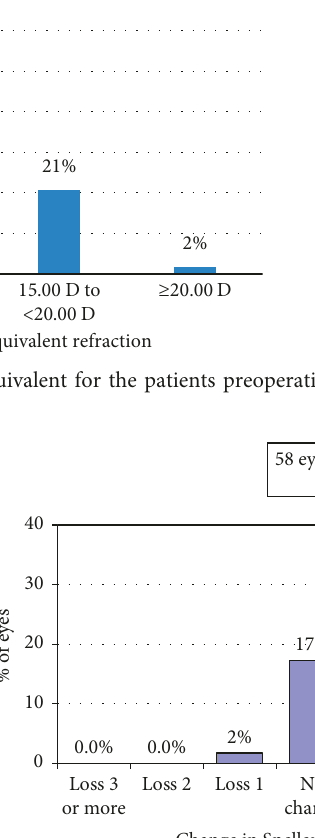
Figure 2: Postoperative uncorrected distance visual acuity (UDVA) versus preoperative corrected distance visual acuity (CDVA).